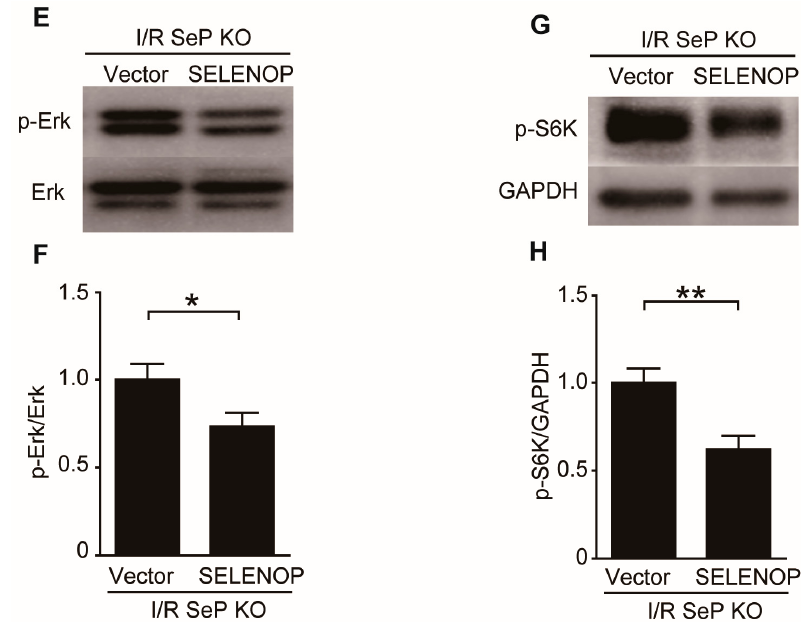
Figure 5. Hepatic overexpression of SeP impairs the reperfusion injury salvage kinase. Human SELENOP or control plasmid-administered SeP KO mice were subjected to 30 min of myocardial ischemia and 2 h of reperfusion. Representative Western blots of ( A ) phosphorylated-IGF1R and GAPDH, ( C ) phosphorylated-serine473-Akt and total Akt, ( E ) phosphorylated-Erk1/2 and total Erk1/2, and ( G ) phosphorylated-p70S6K and GAPDH. Quantification is show in ( B ) p-IGF1R/GAPDH, ( D ) p-Akt/t-Akt, ( F ) p-Erk/t-Erk, and ( H ) p-S6K/GAPDH. Data are represented as means ± SEM from at least five mice each. * p < 0.05, ** p < 0.01.